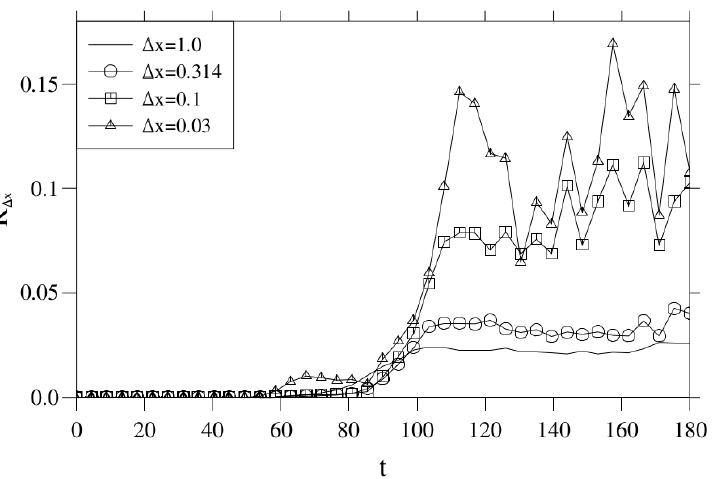
Figure 8. Alfvén ratio e − / e + as a function of time for averages over different length scales to be compared with Figure